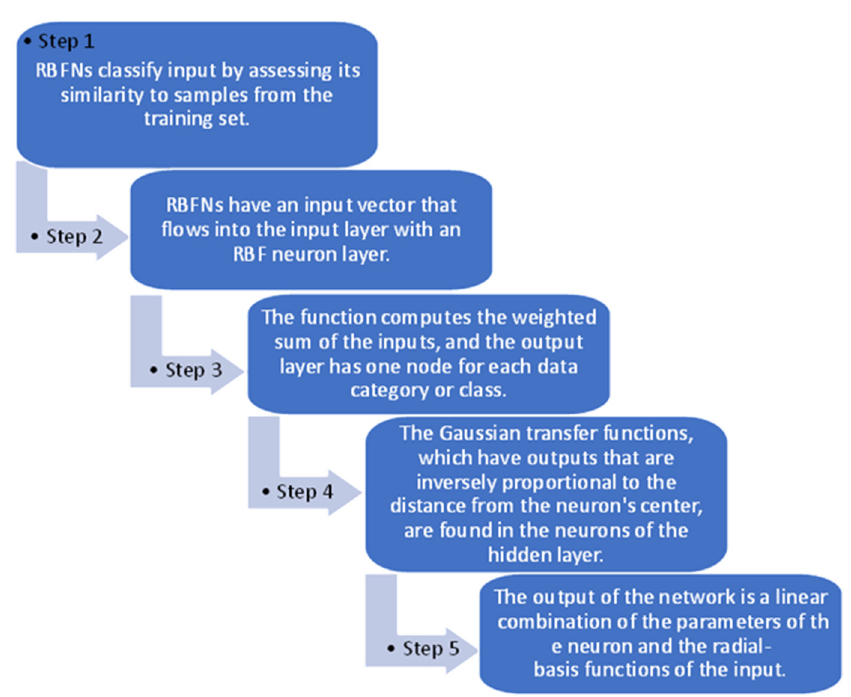
Figure 5. A method through which RFBNs function.